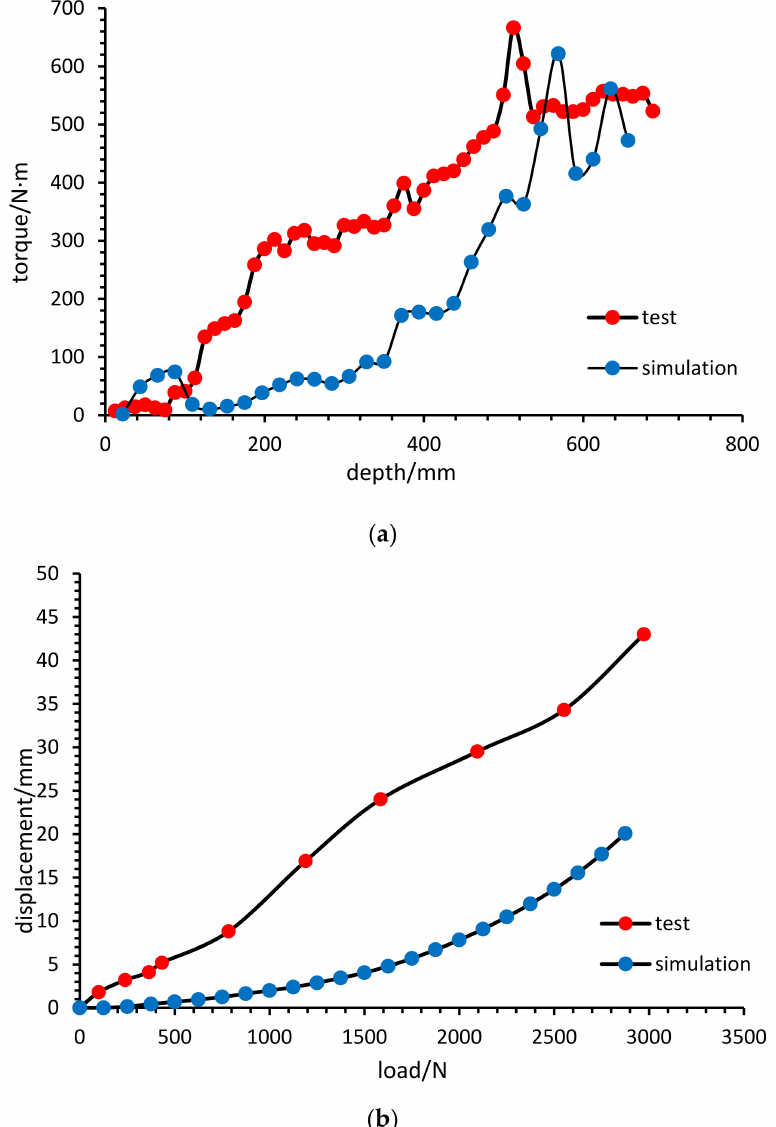
Figure 10. ( a ) The pile installation of progress test; ( b ) Load displacement test of spliced